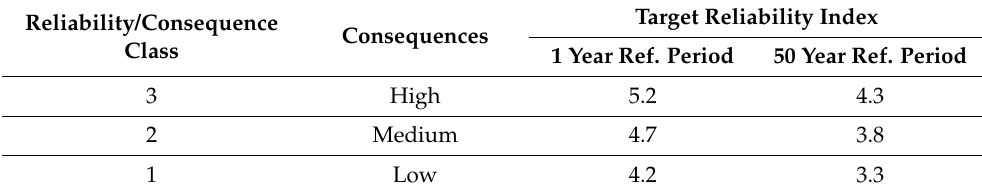
Table 3. Target β -values for elements per EN 1990.